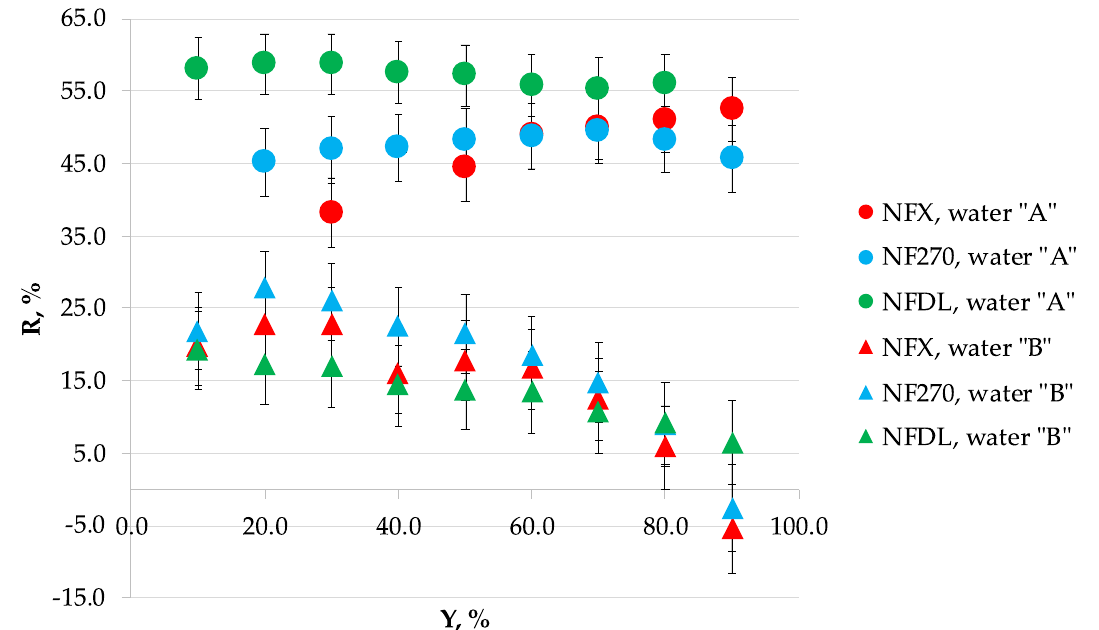
Figure A4. Rejection coefficient, R, of Mg 2+ ‐ as a function of permeate recovery, Y, for NFX, NF270 and NFDL nanofiltration membranes and mine waters “A” (0.384 g/L as Cl − , 1.02 g/L as SO 42 − , 0.107 g/L as Na + , 0.142 g/L as Mg 2+ , 0.312 g/L as Ca 2+ ) and “B” (33.2 g/L as Cl − , 0.937 g/L as SO 42 − , 19.5 g/L as Na + ,